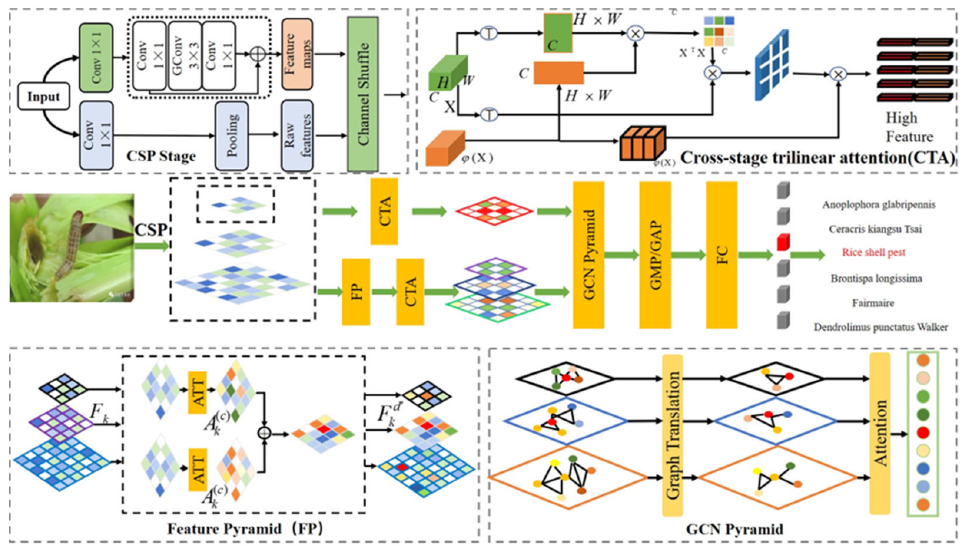
Figure 1. The proposed graph pyramid attention neural network approach, which consists of three essential modules: the cross-stage trilinear attention module to extract potential relations, the feature pyramid to exploit different granularity levels, and the adoption of the GCN pyramid to embed high ‐ dimensional features.